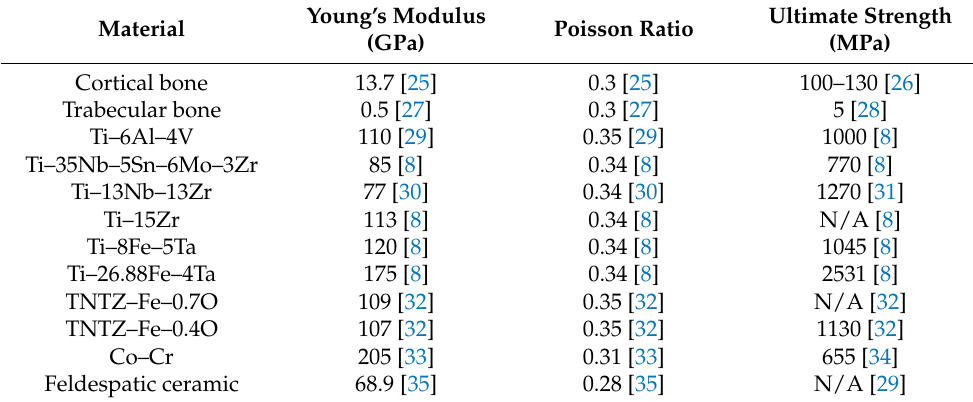
Table 1. Mechanical properties of the materials.